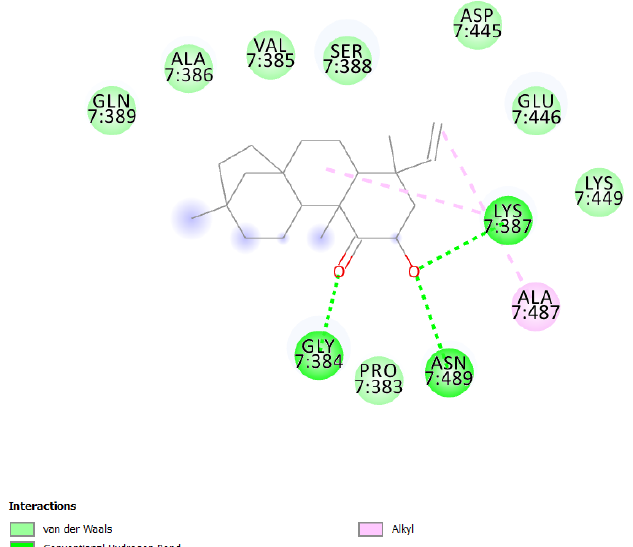
Figure 1. MCM7 protein-interacting residues with UEFS99. Different color code represent the residual interaction types.